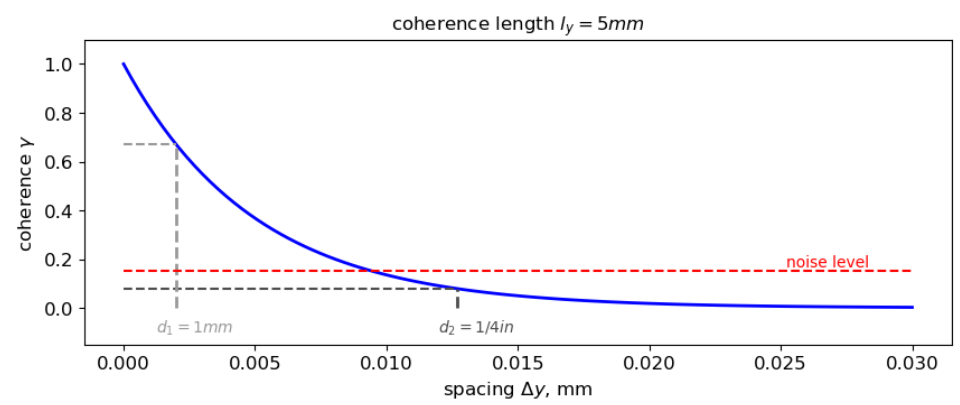
Figure 3. Different sensor sizes allow for different sensor spacings. The level of coherence between two signals from sensors spaced closer together is high, allowing for the determination of the coherence drop even at higher noise